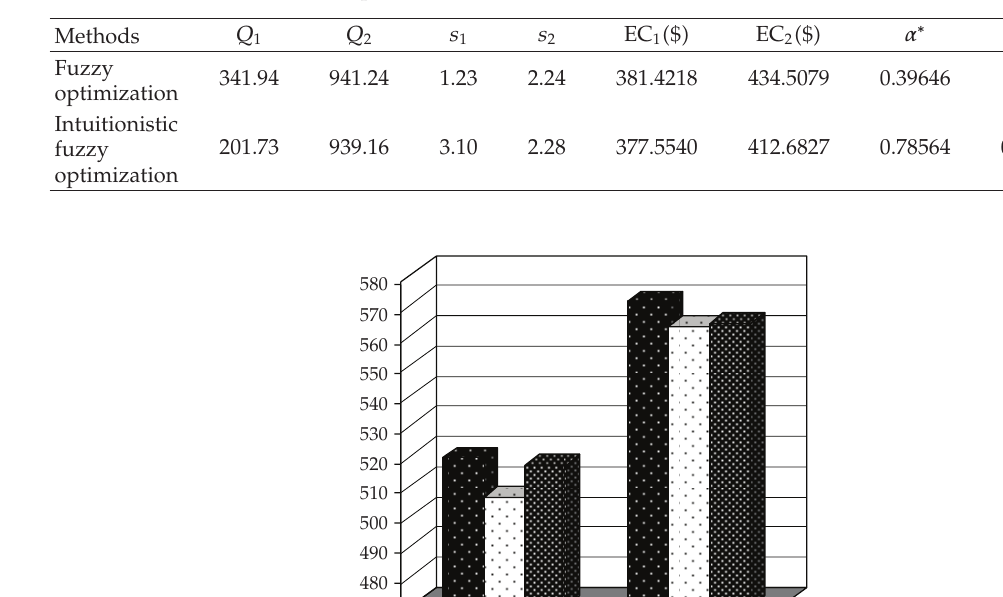
Table 3: Comparison of solutions of FO and IFO (cid:5) EXPONENTIAL (cid:6)